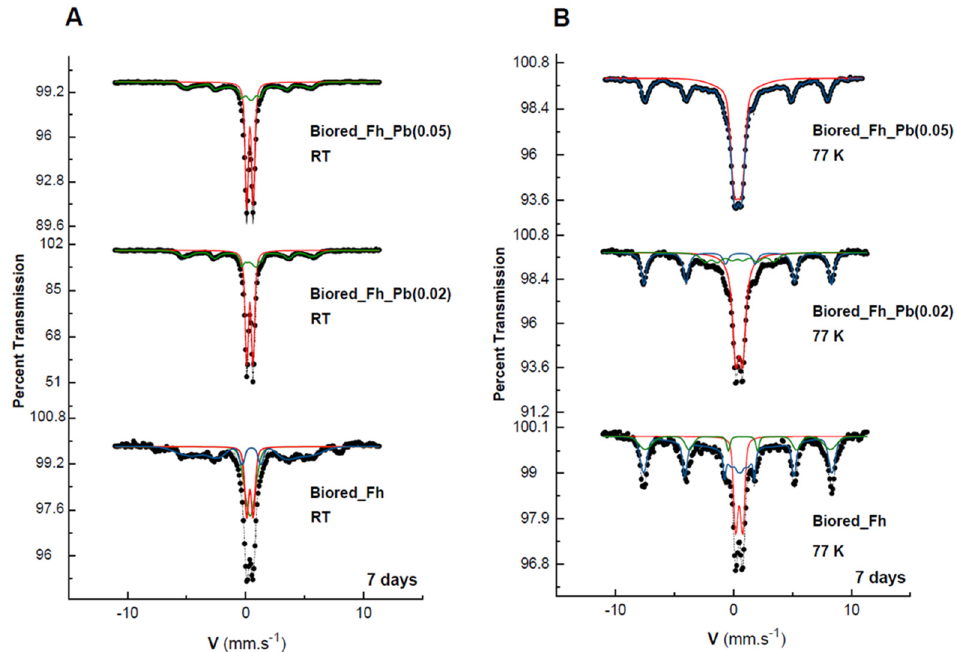
Figure 3. Mössbauer spectra of the secondary products obtained in the Fh, Fh_Pb(0.02), and Fh_Pb(0.05) systems at: ( A ) room temperature (RT), and ( B ) 77 K after the RP1 with Shewanella oneidensis MR-1. Hyperfine parameters that correspond to these spectra are presented in Table 1. Table 1. Mössbauer hyperfine parameters of the spectra of the Fh, Fh_Pb(0.02), and Fh_Pb(0.05) secondary minerals obtained after the RP1 with Shewanella oneidensis MR-1, presented in Figure 3. CS: center shift relative to α Fe; Δ : quadrupole splitting; ε : quadrupole shift; H: hyperfine magnetic field; and RA: relative area.